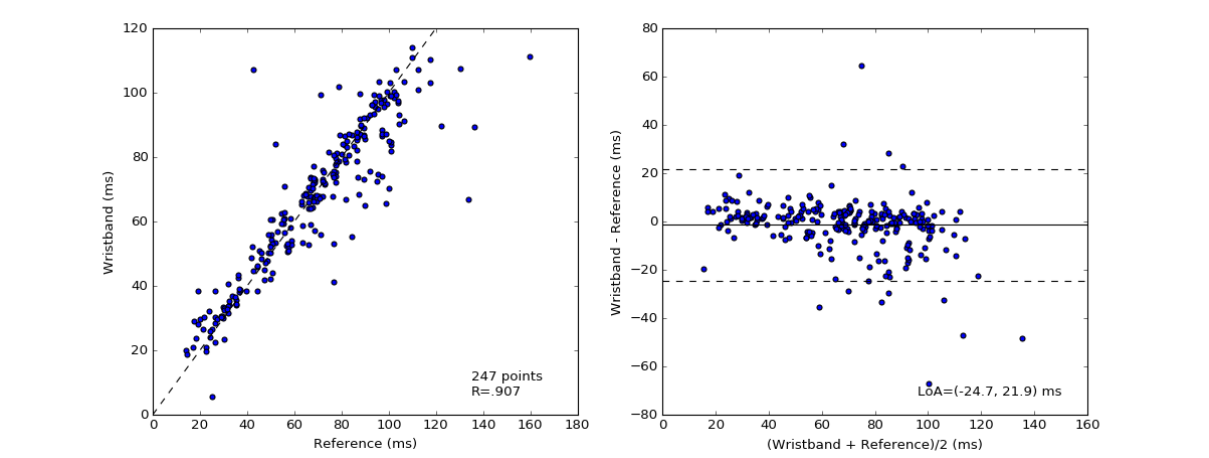
Figure 7. The distribution of measured heart rate variability standard deviation of normal-to-normal intervals (HRV SDNN) by the electrocardiography (ECG) and the wristband (left). The Pearson correlation coefficient is shown in the lower-right corner of this scatter plot. Bland-Altman plots of the absolute error of HRV between the wristband and the simultaneously recorded ECG measurements versus the mean of the measurements in milliseconds (right). The solid black line indicates the mean difference. The dotted lines mark the 95% limits of agreement (LoA) at −25 and 22